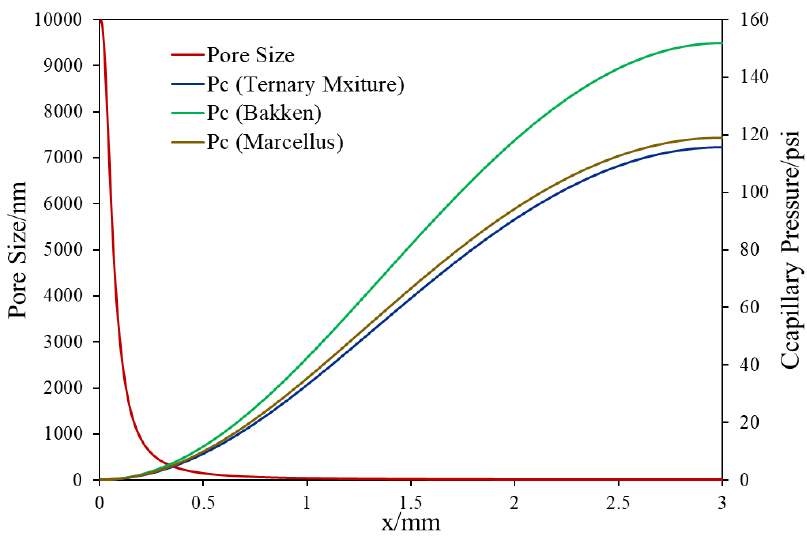
Figure 2. Pore size and capillary pressure distribution for the 2-D core-scale simulation